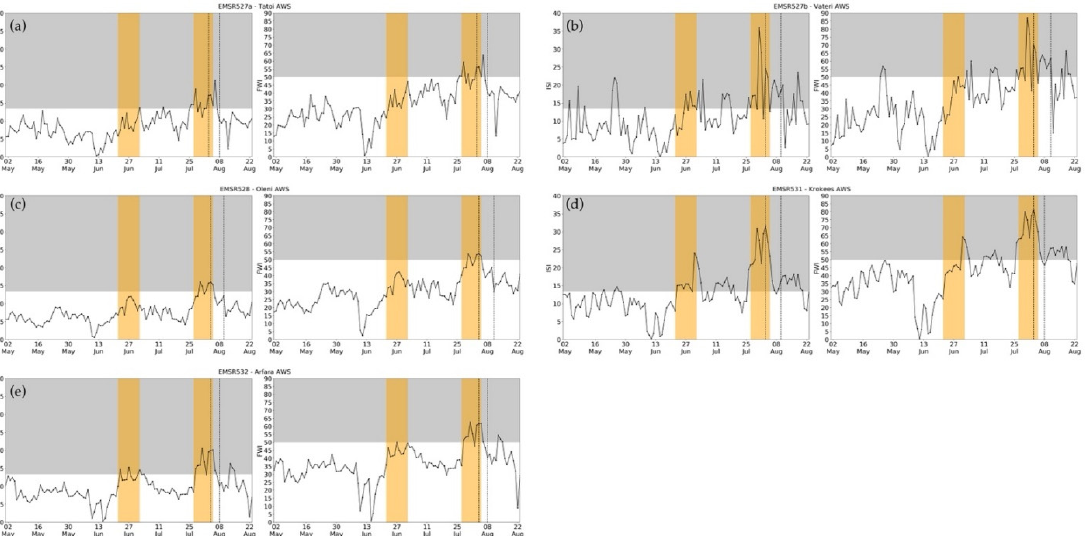
Figure 5. Time series of ISI and FWI during the fire season (May–August) of 2021: ( a ) Tatoi AWS- EMSR527a, ( b ) Vateri AWS-EMSR527b, ( c ) Oleni AWS-EMSR528, ( d ) Krokees AWS-EMSR531, and ( e ) Arfara AWS-EMSR532. The yellow-shaded areas delineate heatwave periods. The grey-shaded areas denote ISI and FWI values corresponding to “Very high” and “Extreme” fire danger according to EFFIS.